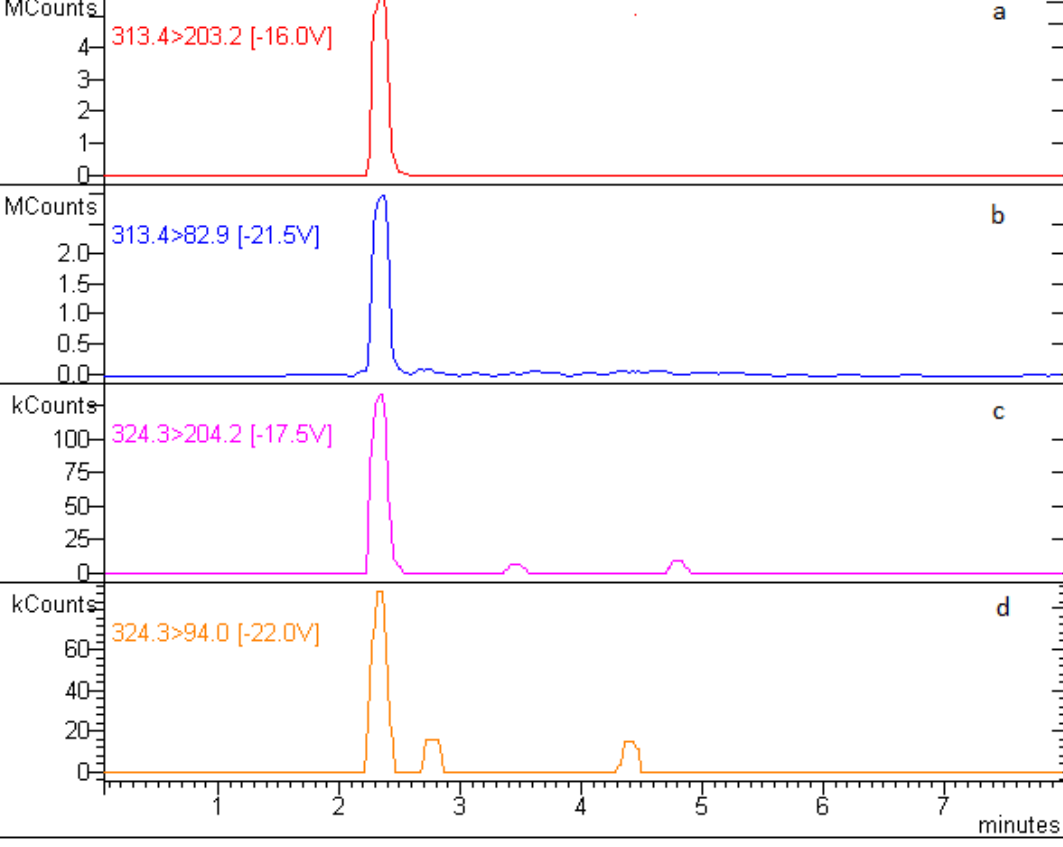
Figure 4. Chromatogram of Sparus aurata muscle sample after six days of in-feed treatment with PZQ 50 mg/kg BW. ( a ) main PZQ transition; ( b ) second PZQ transition; ( c ) main IS transition; ( d ) second IS transition.